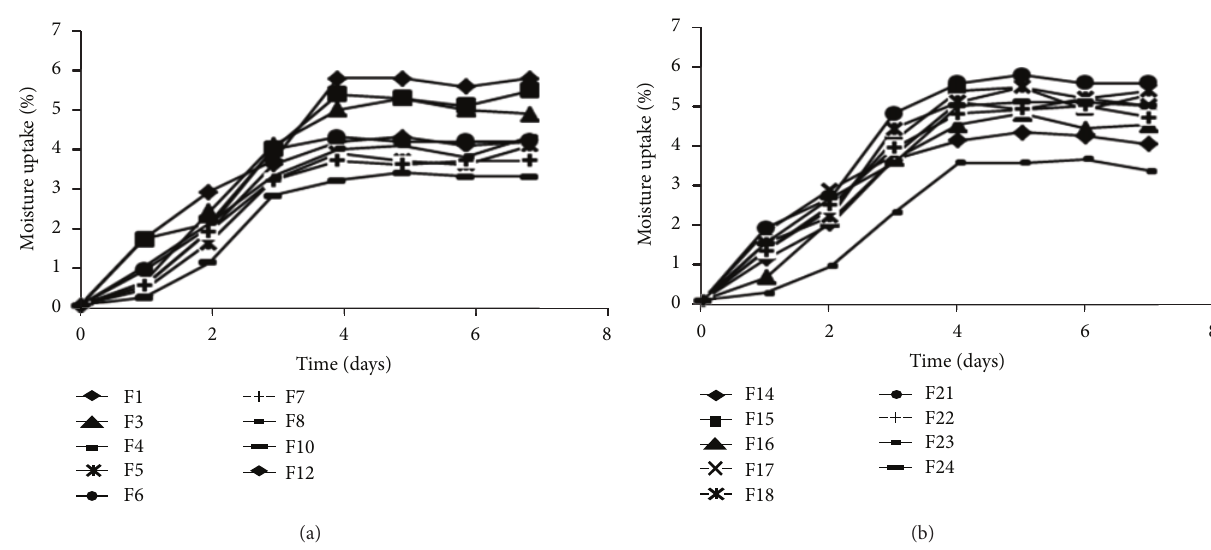
Figure 5: Moisture uptake analysis: (a) formulations containing glycerine and (b) formulations containing PEG 400.